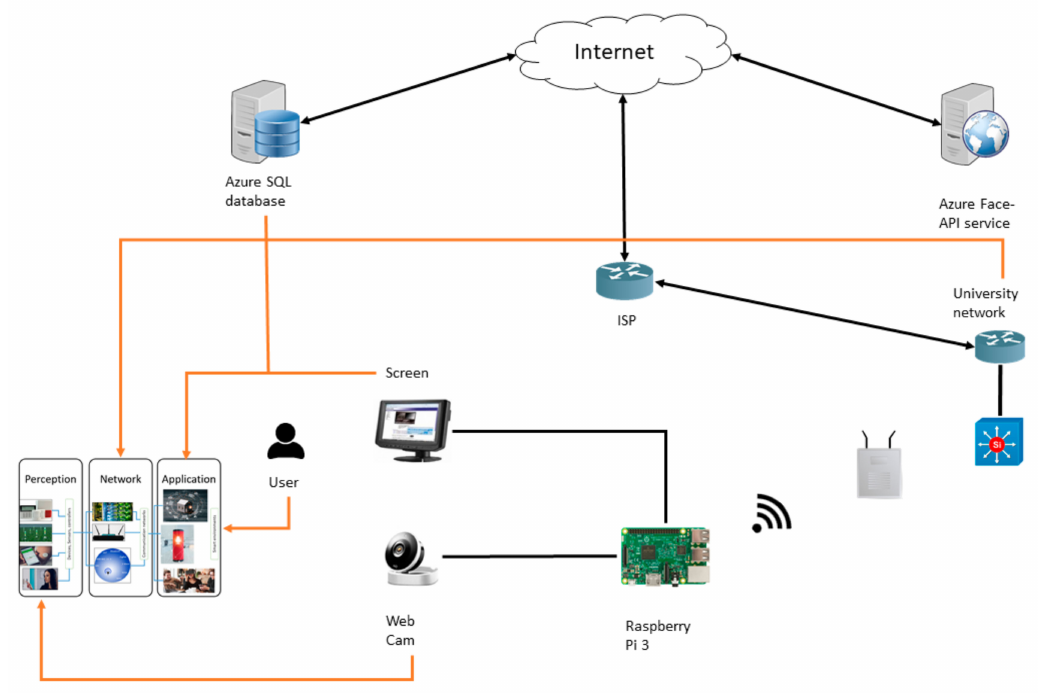
Figure 6. Scheme of an IoT model for security management on university